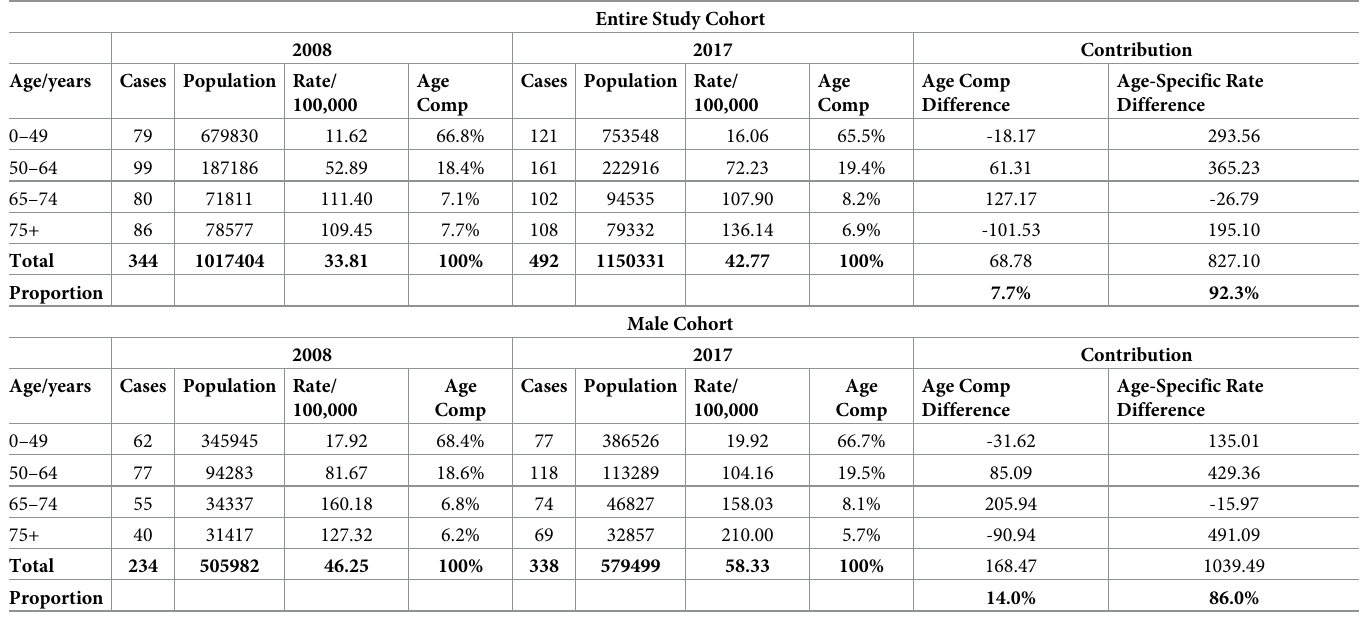
Table 2. The contribution of changes in age group distribution and age-specific rates on